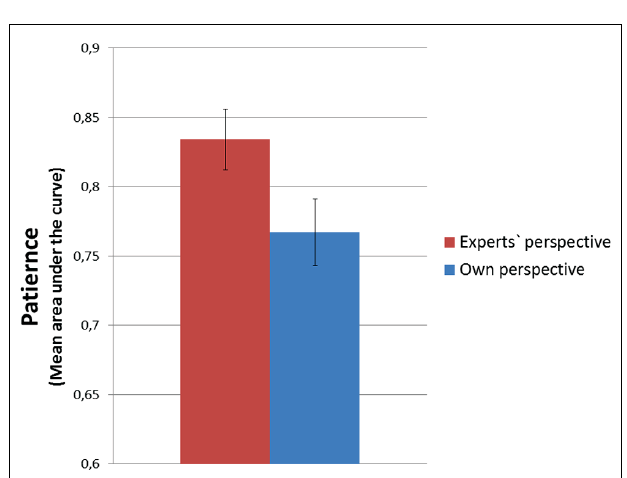
FIGURE 5 | Discounting strength for delayed